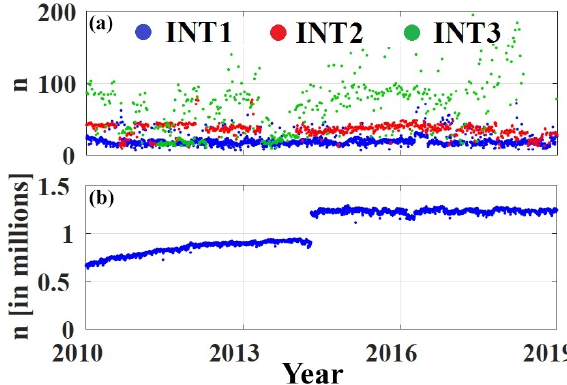
/ N GNSS for different parameter groups (mean ii ii